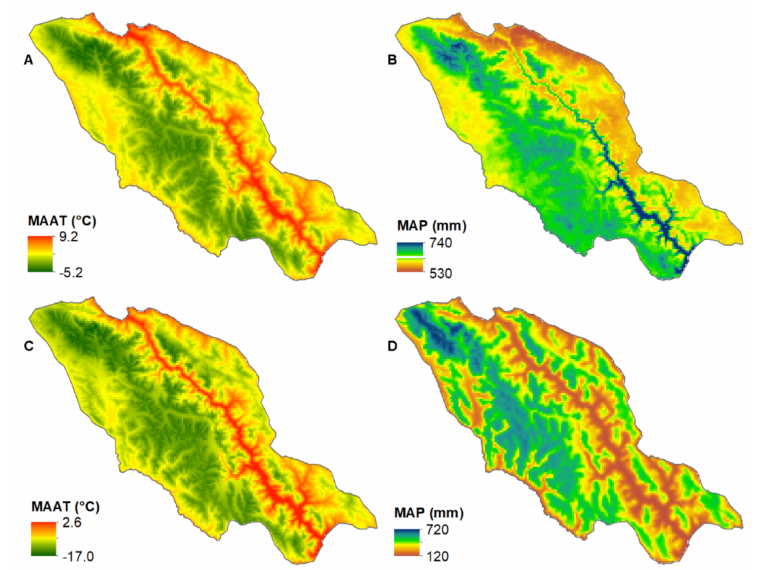
Figure 2. ( A ) Modern mean annual air temperature, ( B ) modern mean annual precipitation, ( C ) mean annual temperature and ( D ) mean annual precipitation during the Last Glacial Maximum.